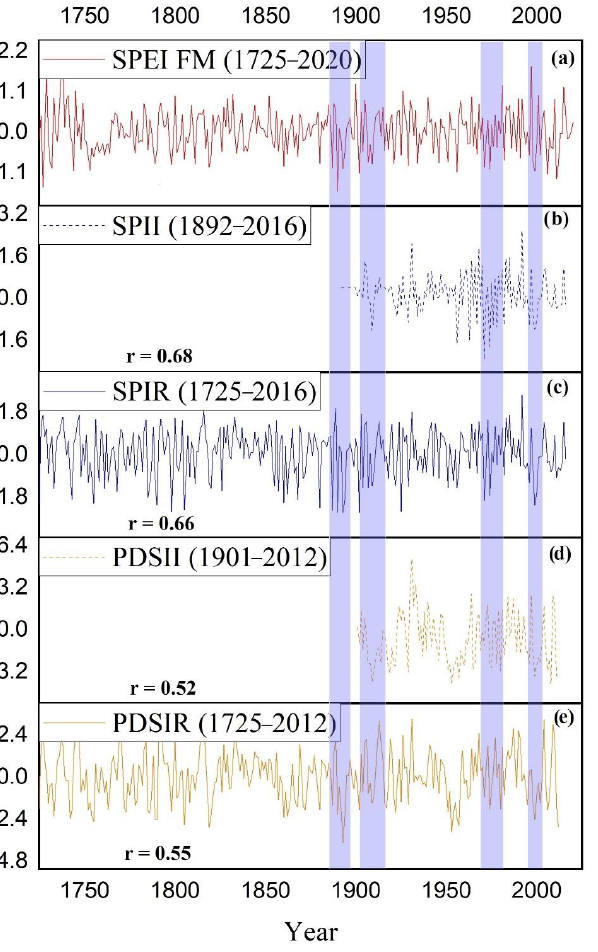
Figure 7. Temporal variation for different drought indices, reconstructed SPEI ( a ), instrumental SPI ( b ), reconstructed SPI [40] ( c ), instrumental PDSI ( d ), and reconstructed PDSI [18] ( e ). Pearson’s correlation coefficients ( r ) between drought indices and SPEI6 FM are indicated in every panel. The blue shaded lines represent periods of common severe droughts in the different analyzed indices and the reconstructed SPEI.